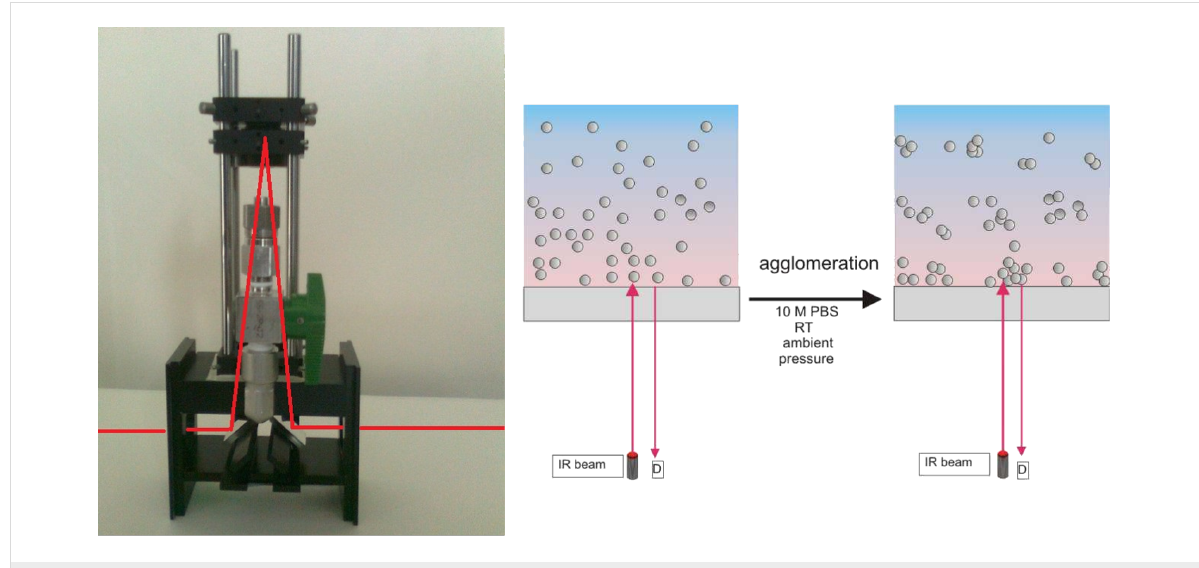
Figure 4: Photo of the RIfS Setup with inserted light path (left); RIfS transducer with nanoparticle solution